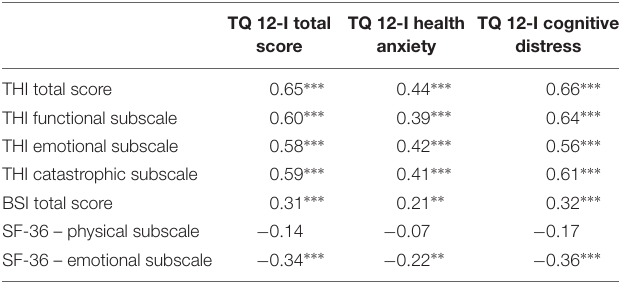
TABLE 4 | Correlations between TQ 12-I, THI, BSI, and SF-36.